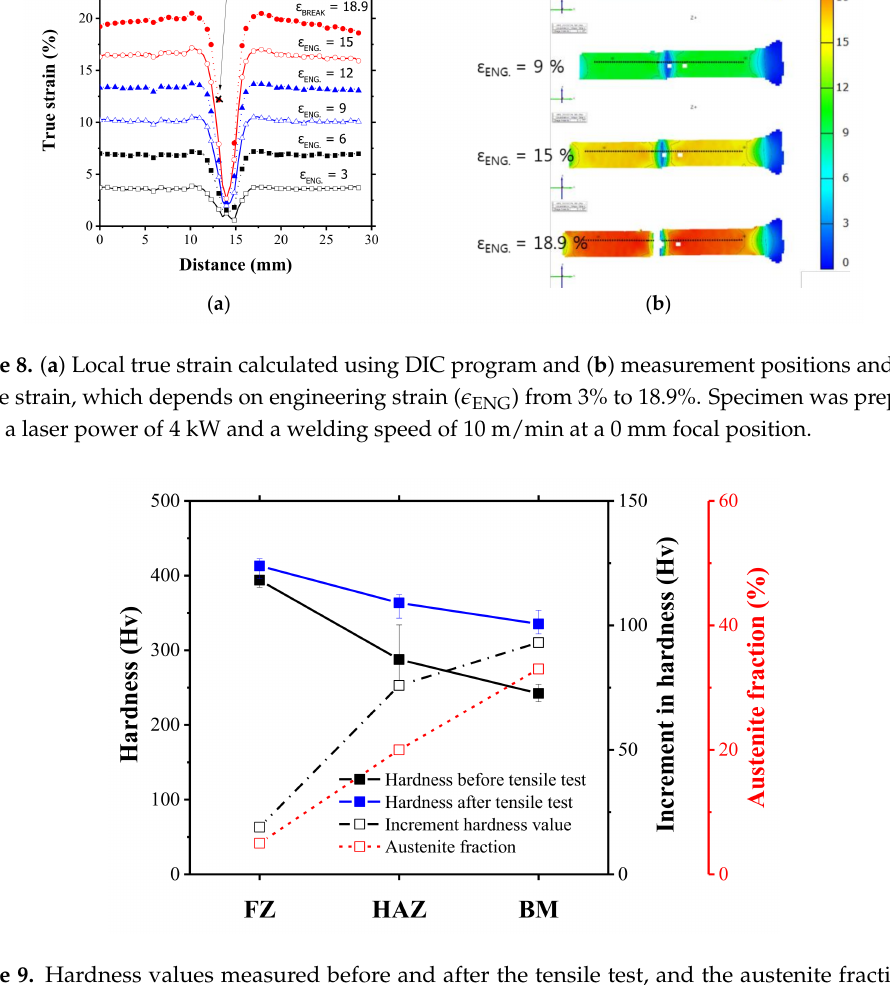
Figure 9. Hardness values measured before and after the tensile test, and the austenite fraction in the welds. Specimen was prepared using a laser power of 4 kW and a welding speed of 11 m/min.